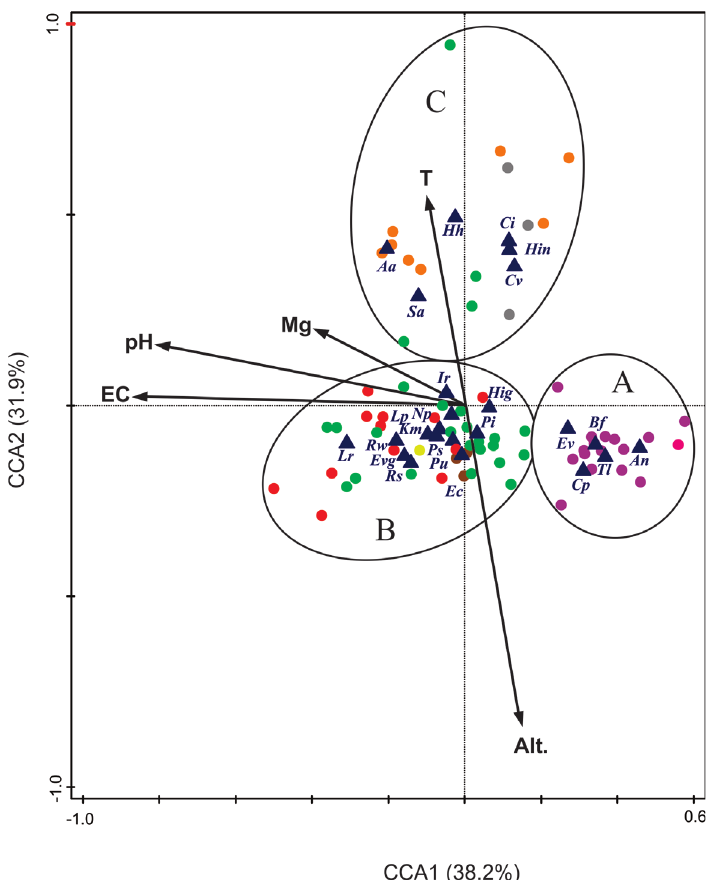
Figure 5. Canonical Correspondence Analysis triplot shows the relationships between 23 species (triangles), selected physicochemical environmental variables (arrows; temperature = T, pH, electrical conductivity = EC, altitude = Alt., Mg=Mg concentration), and sites (points). Colour site points: pink cluster 1, yellow